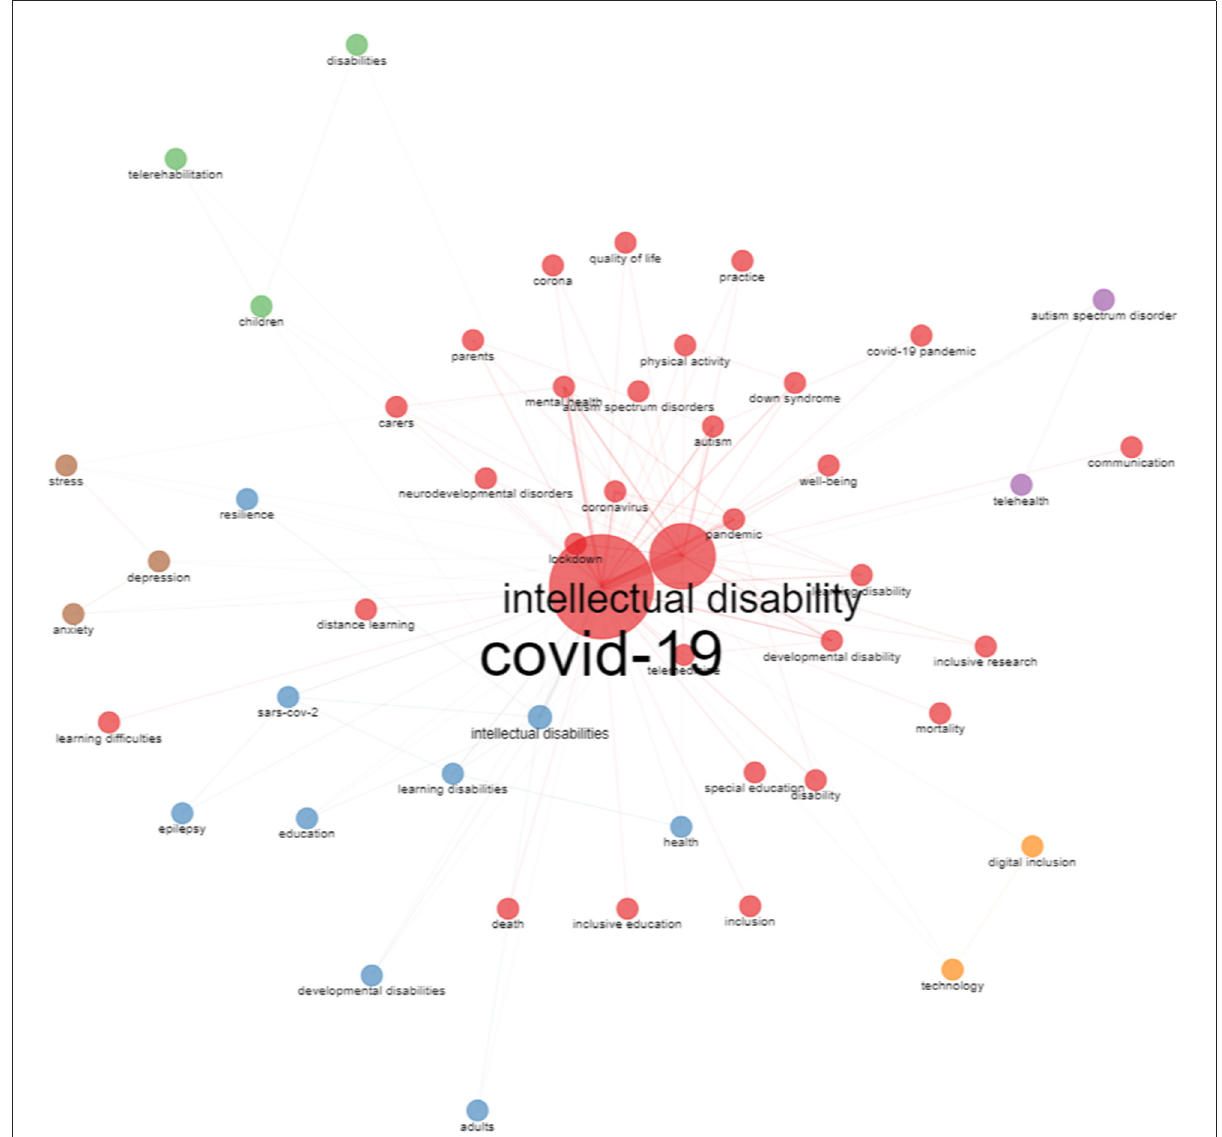
FIGURE3 An overview of the co-occurrence of keywords. The nodes and linking lines between them represent the keywords and their co-occurrence relationships,